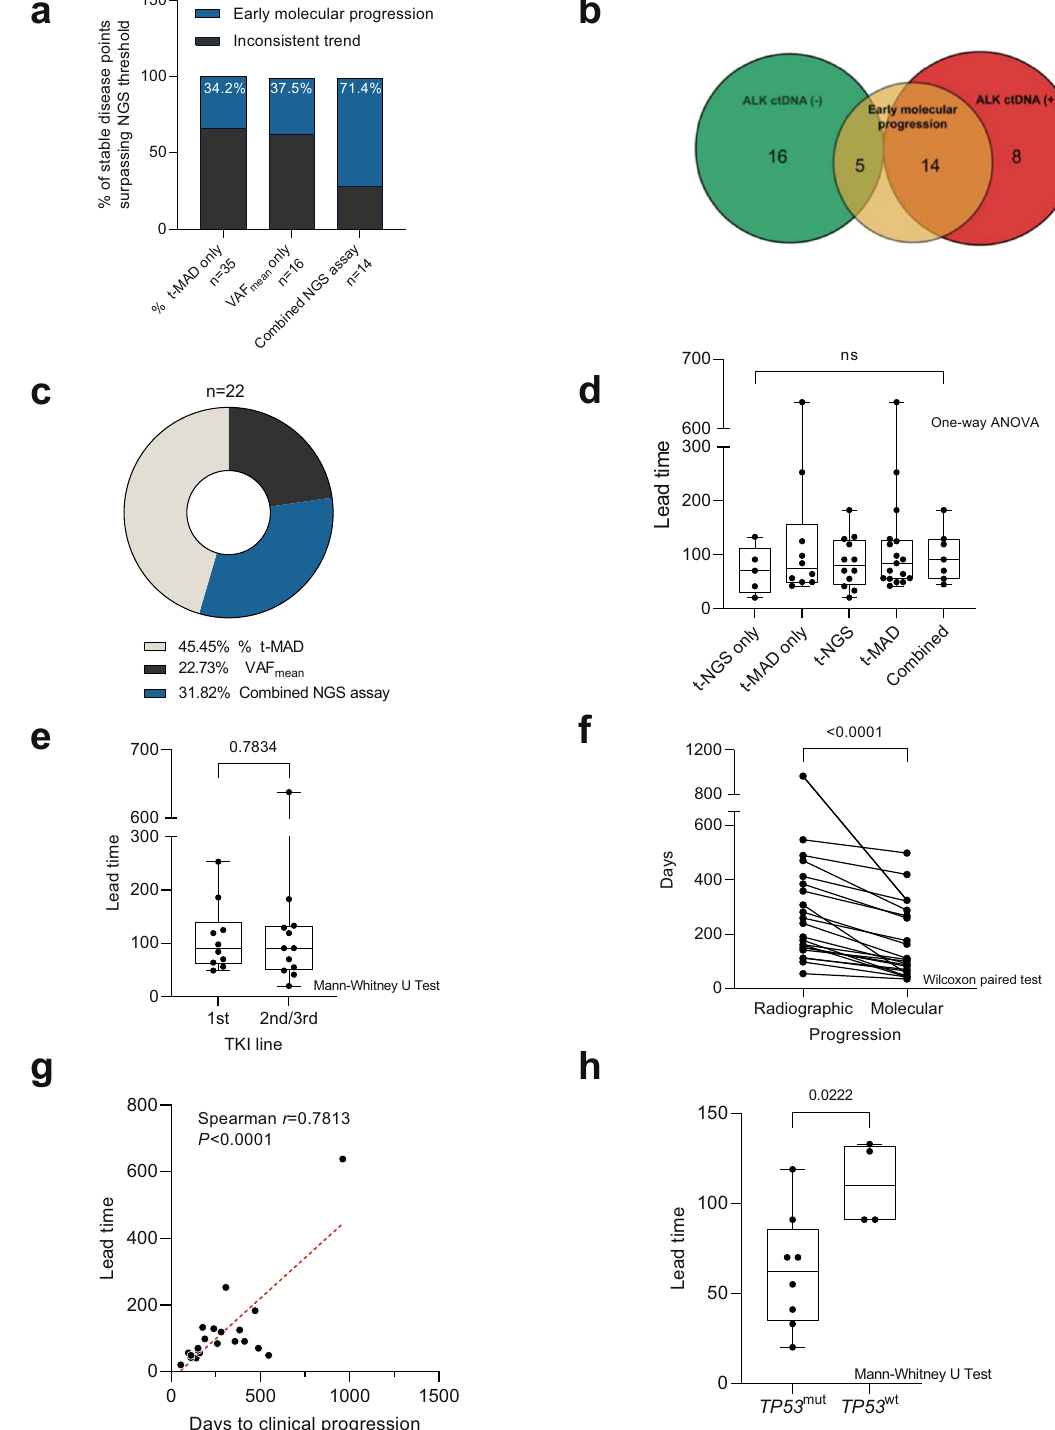
Fig. 3 Evaluation of the utility of Δ VAF mean and % Δ t-MAD in identifying early molecular progression. a Number of stable disease points that surpassed the numerical cutoffs per individual NGS assay (% Δ t-MAD or Δ VAF mean ) and in combination. Gray stacks indicate the percentage of points with inconclusive NGS assay values leading to clinical progression. Blue stacks represent points that showed sustained % fi ed with early Δ t-MAD and/or Δ VAF mean increase leading to clinical progression, indicating early molecular progression. b Patients identi molecular progression were enriched in the ALK ctDNA ( + ) group. c Breakdown of 22 patients with early molecular progression based on NGS assays. d Comparison of called lead times based on NGS assays. e Comparison of called lead times based on therapy lines. f Comparison of cases with called lead time showing signi fi cant difference in days to radiographic progression versus molecular progression. g Length of lead time per therapy line was signi fi cantly correlated with duration of progression-free response to the respective treatment. h Lead times in cases with wild-type TP53 ( TP53 wt ) were signi fi cantly longer compared to cases with mutated TP53 ( TP53 wt ) detected by tNGS. The box plot show the the median, upper quartile, and lower quartile values. The whiskers indicate minimum and maximum